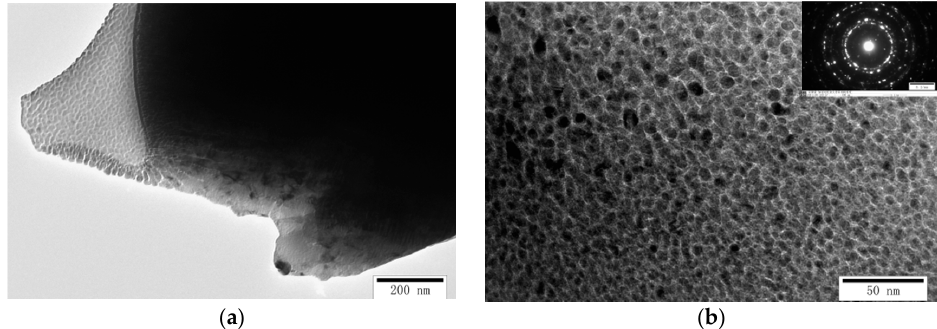
Figure 11. Microstructure of the Area-A of the blanked edge prepared under ultra-high blanking speed (SPM 3000). ( a ) TEM morphology; ( b ) Nano-grains.